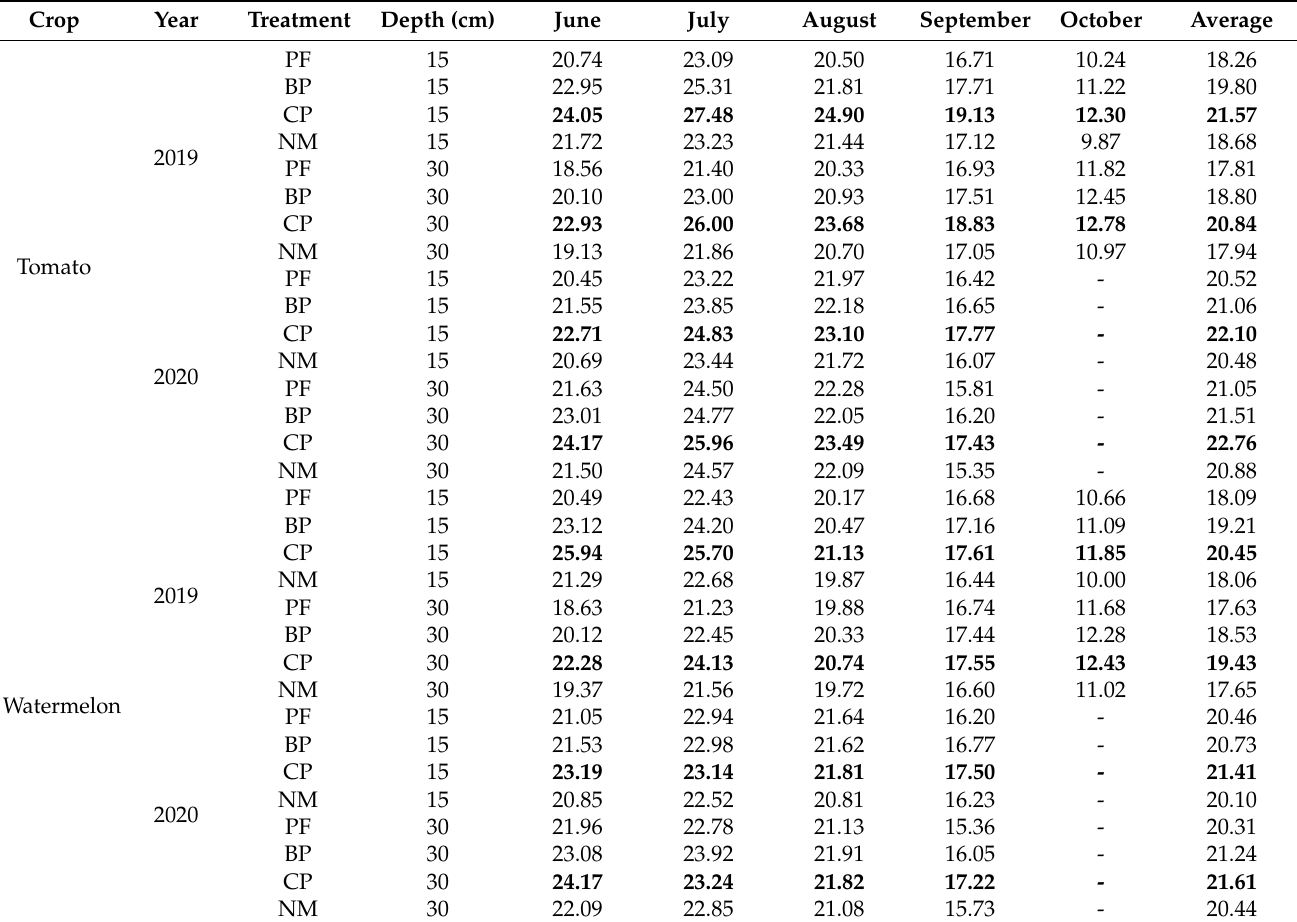
Table 5. Monthly average soil temperature ( ◦ C) under clear plastic mulch (CP), black plastic mulch (BP), landscape fabric mulch (PF), and no mulch (NM) in no-irrigation plots. Crop Treatment Depth (cm)